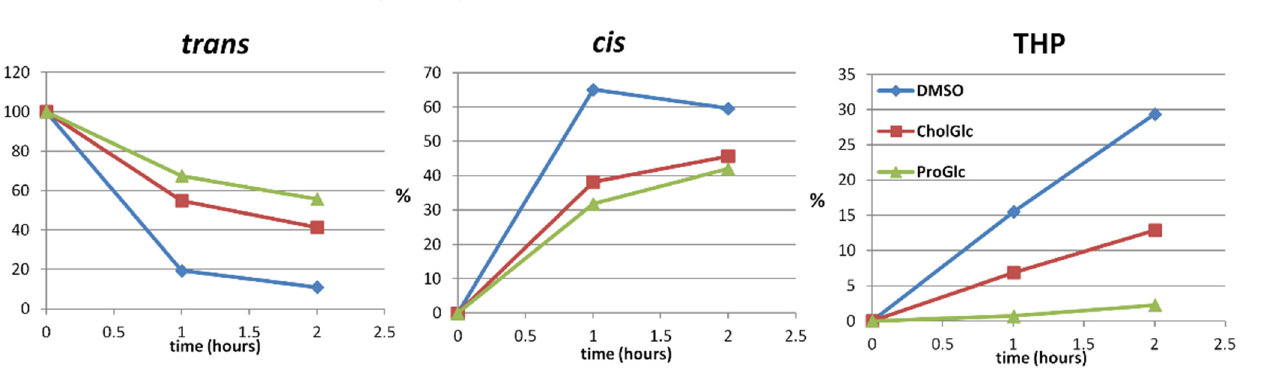
Figure 7. Resveratrol sunlight-induced photochemical isomerization and THP formation in the presence of different NaDES. DMSO was utilized as the control solvent.